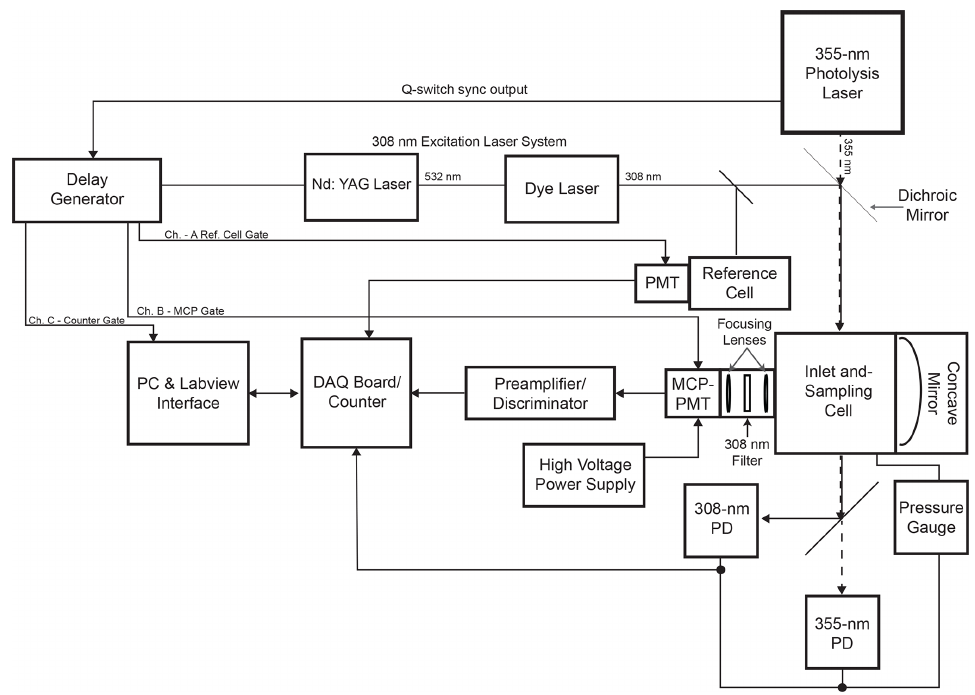
Figure 1. Schematic diagram of the LP/LIF instrument.